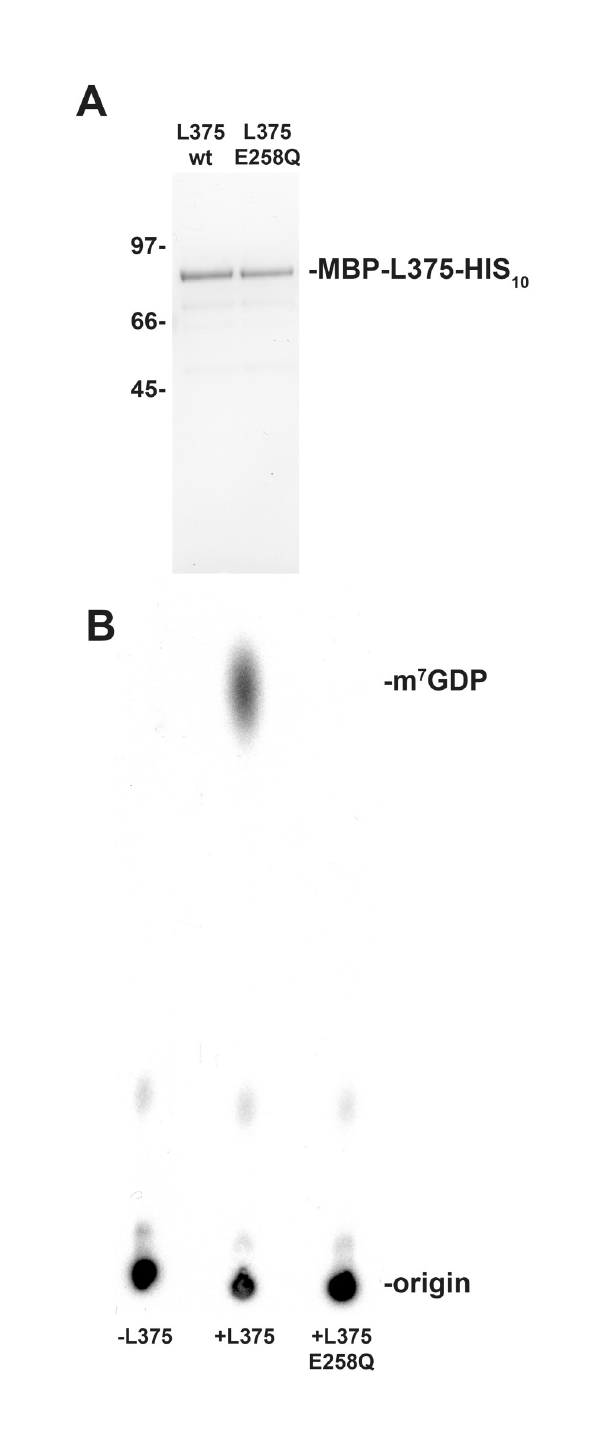
Fig 3. The mRNA decapping activity of recombinant L375 is dependent on an intact Nudix hydrolase motif. (A) The Nudix motif of MBP-L375-HIS 10 was subjected to site- directed mutagenesis to convert the first glutamic acid of the EX 2 EE active site at position 258 into a glutamine residue, thereby producing L375(E258Q). The mutant and wild- type proteins were expressed and purified in parallel as described in Fig 2A. The purified proteins were resolved by SDS/PAGE and visualized by Coomassie blue staining. The locations of the protein mass standards (in kDa) are